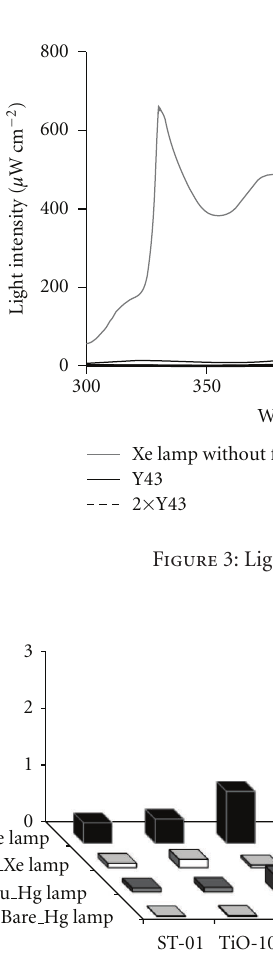
Figure 4: Comparison of rate of photocatalytic acetone evolution from suspensions containing 2-propanol and bare or gold modified titania photocatalysts (ST-01, TIO-10, Aldrich A, ST-G1 and Aldrich R) under vis irradiation with a mercury or a xenon lamp and cut-o ff filter: Y48 ( >